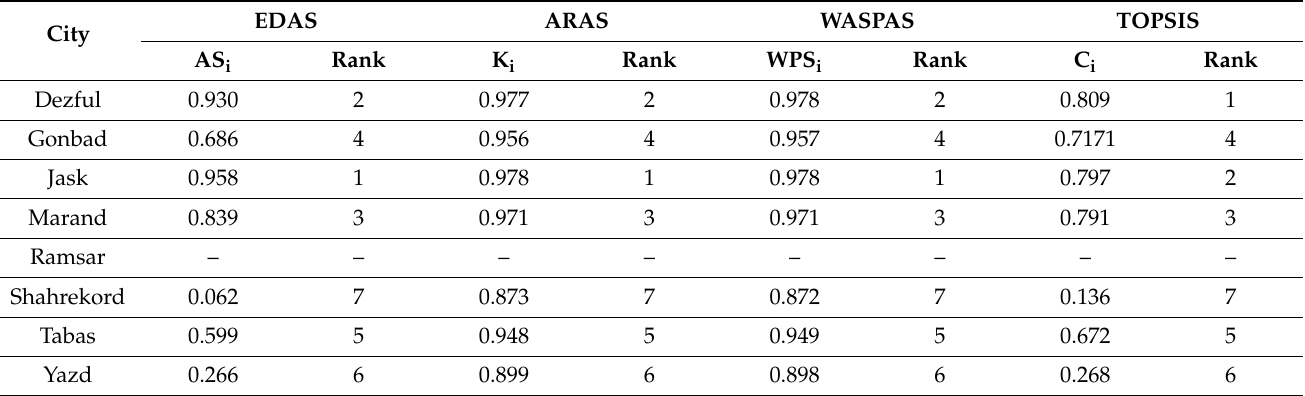
Table 16. Results of ranking of cities on a 90° slope.